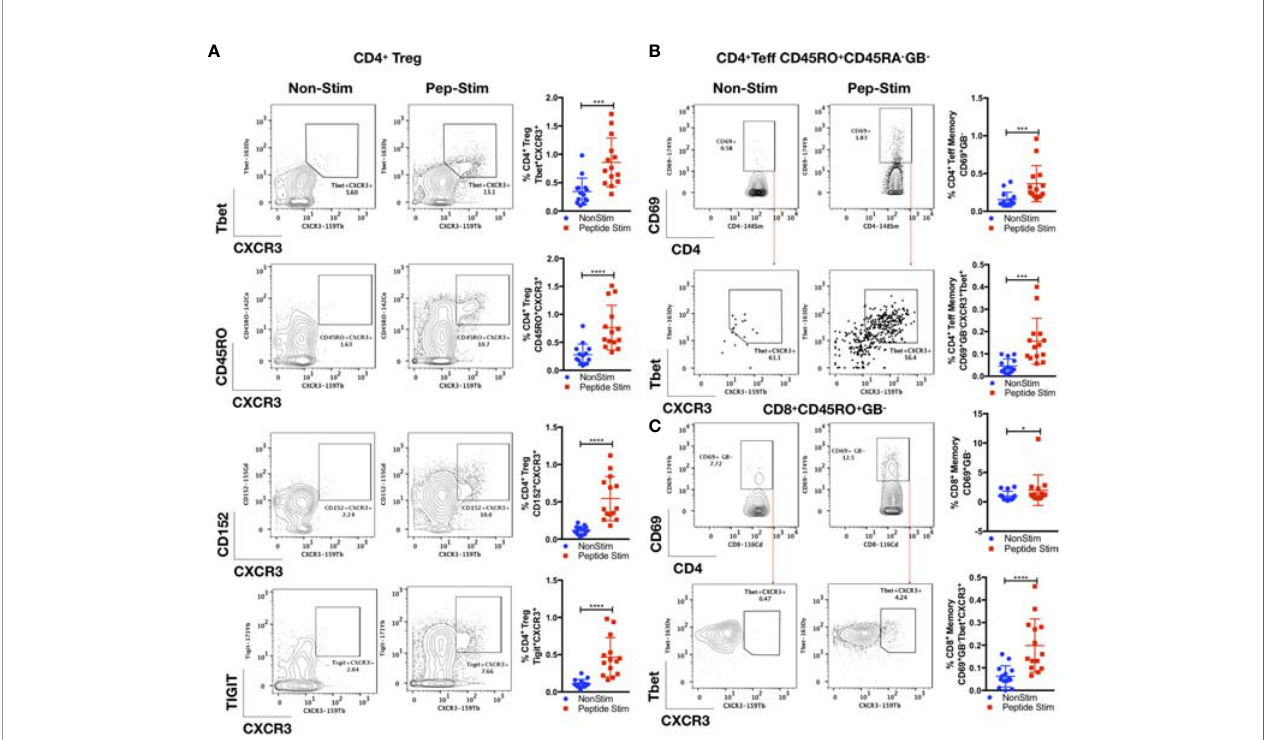
FIGURE 4 | Parallel antigen-speci fi c Th1 responses generated by regulatory and effector subsets. PBMCs from convalescent patients (n = 14) were stimulated for 72 h with/ without a peptide pool covering the RBD of the SARS-CoV-2 spike glycoprotein and interrogated with COVID panel A . (A) Frequencies of CD3 + CD4 + CD25 + FoxP3 + (T reg ) CXCR3 + Tbet + , CD3 + CD4 + CD25 + FoxP3 + (Treg)CXCR3 + CD45RO + , CD3 + CD4 + CD25 + FoxP3 + (T reg )CXCR3 + CD152 + or CD3 + CD4 + CD25 + FoxP3 + (T reg )CXCR3 + TIGIT + as a percentage of CD4 + T cells. (B) Frequencies of CD3 + CD4 + CD25 +/- FoxP3 - (T eff )CD45RO + CD45RA - GB - CD69 + or CD3 + CD4 + CD25 +/- FoxP3 - (T eff )CD45RO + CD45RA - GB - CD69 + Tbet + CXCR3 + . (C) CD8 + CD45RO + CD45RA - GB - CD69 + or CD8 + CD45RO + CD45RA - GB - CD69 + Tbet + CXCR3 + , as a percentage of CD4 + or CD8 + parent T cell lineages. Data represent the mean ± SD, Mann – Whitney U (two-tailed) test, * p < 0.05, *** p < 0.001, **** p < 0.0001. NonStim, peptide solvent control; Peptide Stim, stimulation with peptide